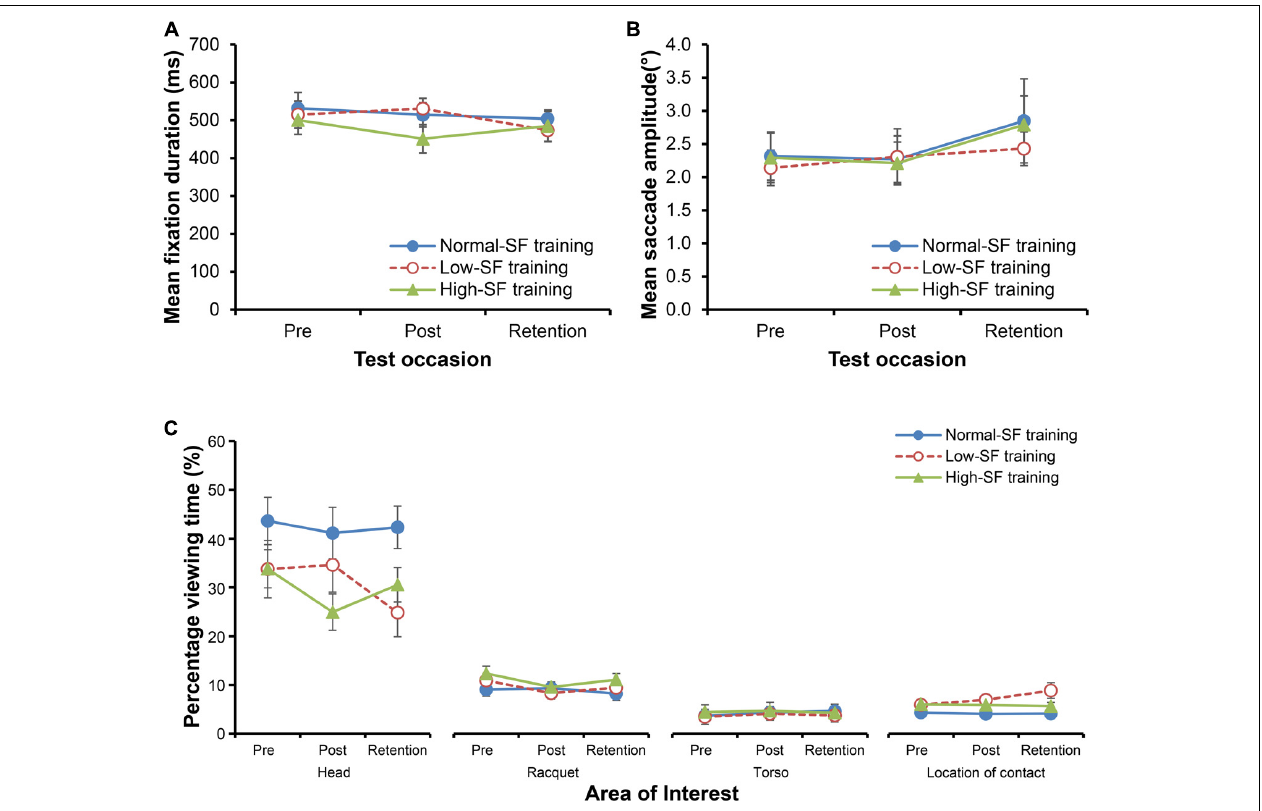
FIGURE 3 | Mean fixation duration (A) and mean saccadic amplitude (B) . Percentage of total viewing time toward each of four key AoIs for each group (C) . To reduce complexity, only the four most frequently fixated AoIs are shown: head, racquet, torso, and location of contact. Error bars indicate the standard error of the mean.